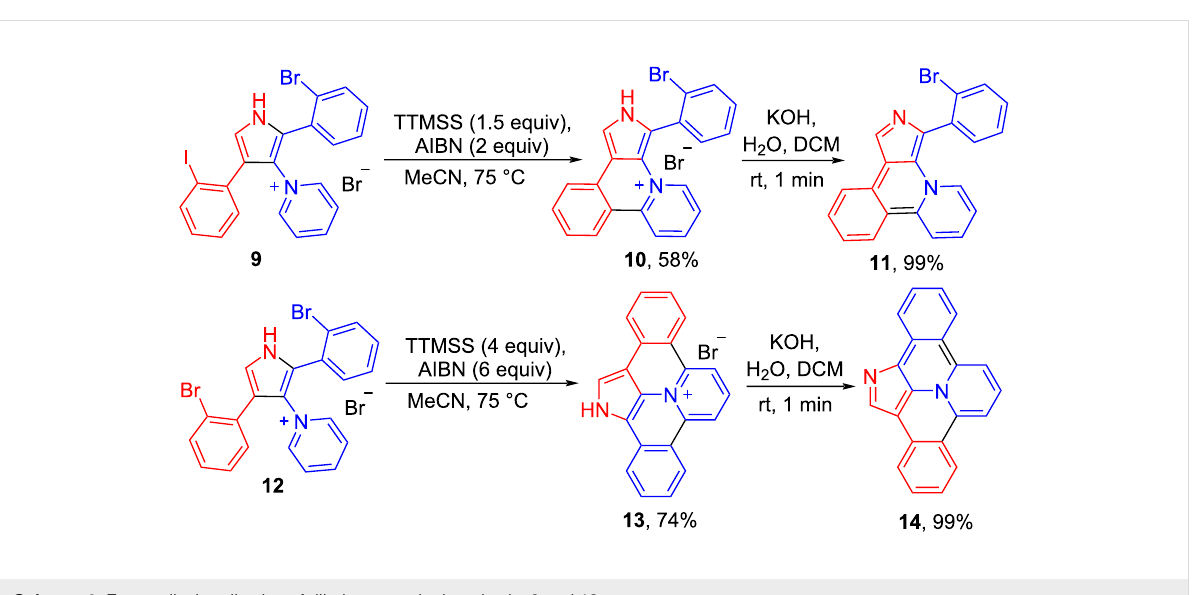
Scheme 4: Free-radical cyclization of dihalogeno-substituted salts 9 and 12 .